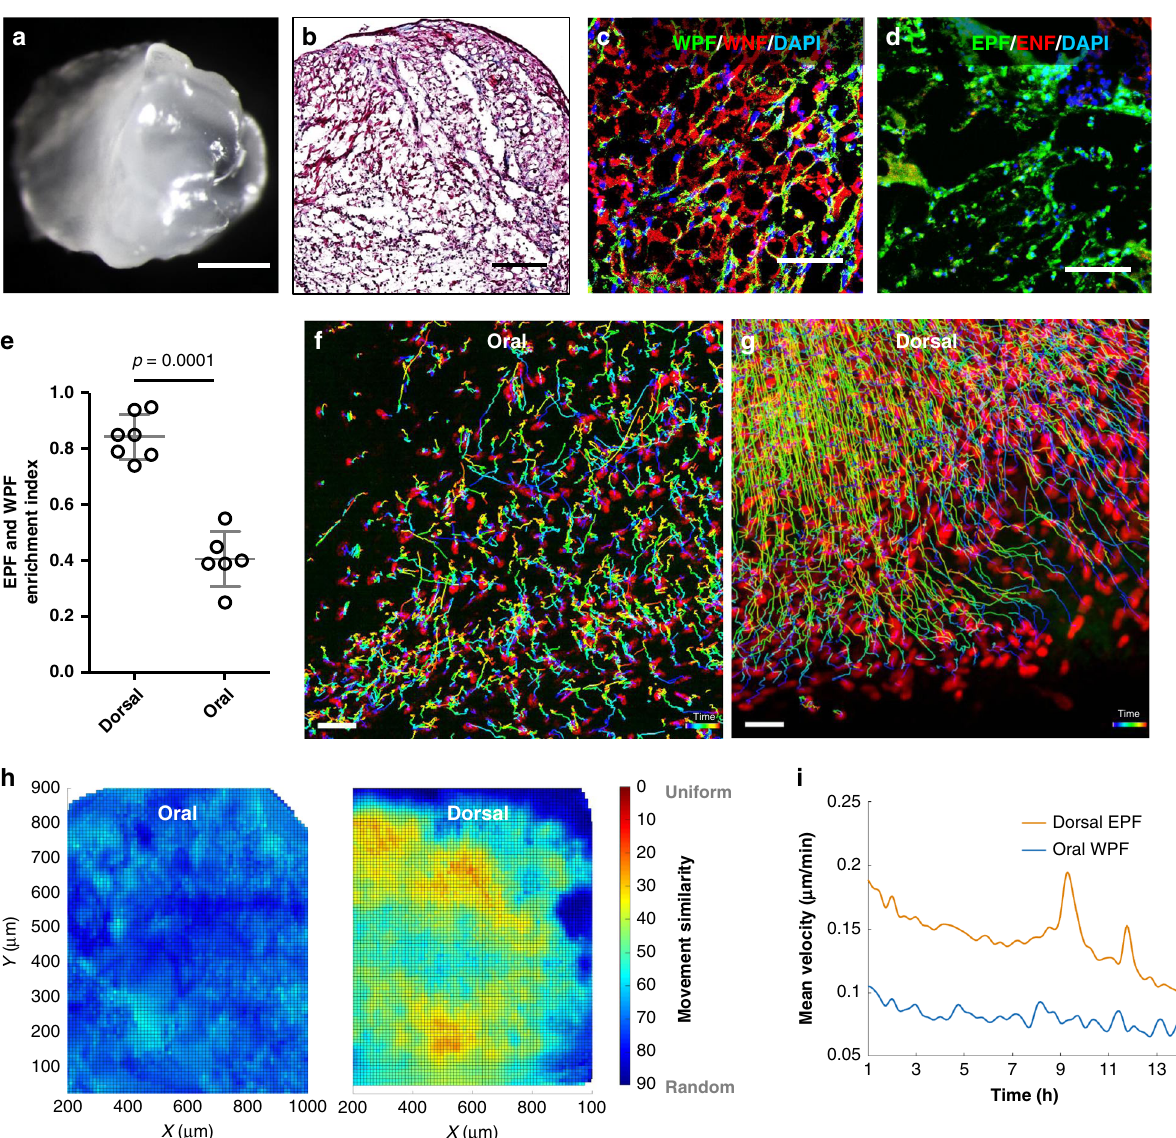
Fig. 3 Fibroblast swarms are absent from oral mucosa SCAD. a , b Whole-mount bright- fi eld image ( a ) and Masson ’ s trichrome staining ( b ) of SCAD from buccal mucosa. n > 30. c , d Fluorescence images of SCAD from Wnt1 Cre ;R26 mTmG buccal mucosa ( c ) and En1 Cre ;R26 mTmG back-skin ( d ). e EPF and WPF enrichment index in day 5 En1 Cre ;R26 mTmG dorsal SCAD or Wnt1 Cre ;R26 mTmG oral SCAD, respectively. Mean ± SD, unpaired two-tailed t -test, p = 0.0001, n = 7/6. f , g Colour-coded tracking of WPFs in oral SCAD ( f , Supplementary Movie 8) or tracking of EPFs in dorsal SCAD ( g ) on a mCherry nuclear reporter (72 – 96 h). The colour indicates the time, with purple at the beginning and red at the end of the movie. Images are representative of three biological replicates. h Movement similarity between WPF and EPF tracks is visualised in a scale from 0 (red, uniform migration) to 90 (blue, random migration). i Comparison of velocities of WPFs in oral SCADs (blue) versus fascia EPFs in dorsal SCAD (orange) over time. Lines shown are smoothing lines over all velocity values at each time point. Scale bars: a = 500 µ m; b = 200 µ m; c , d = 50 µ m; f , g = 30 µ